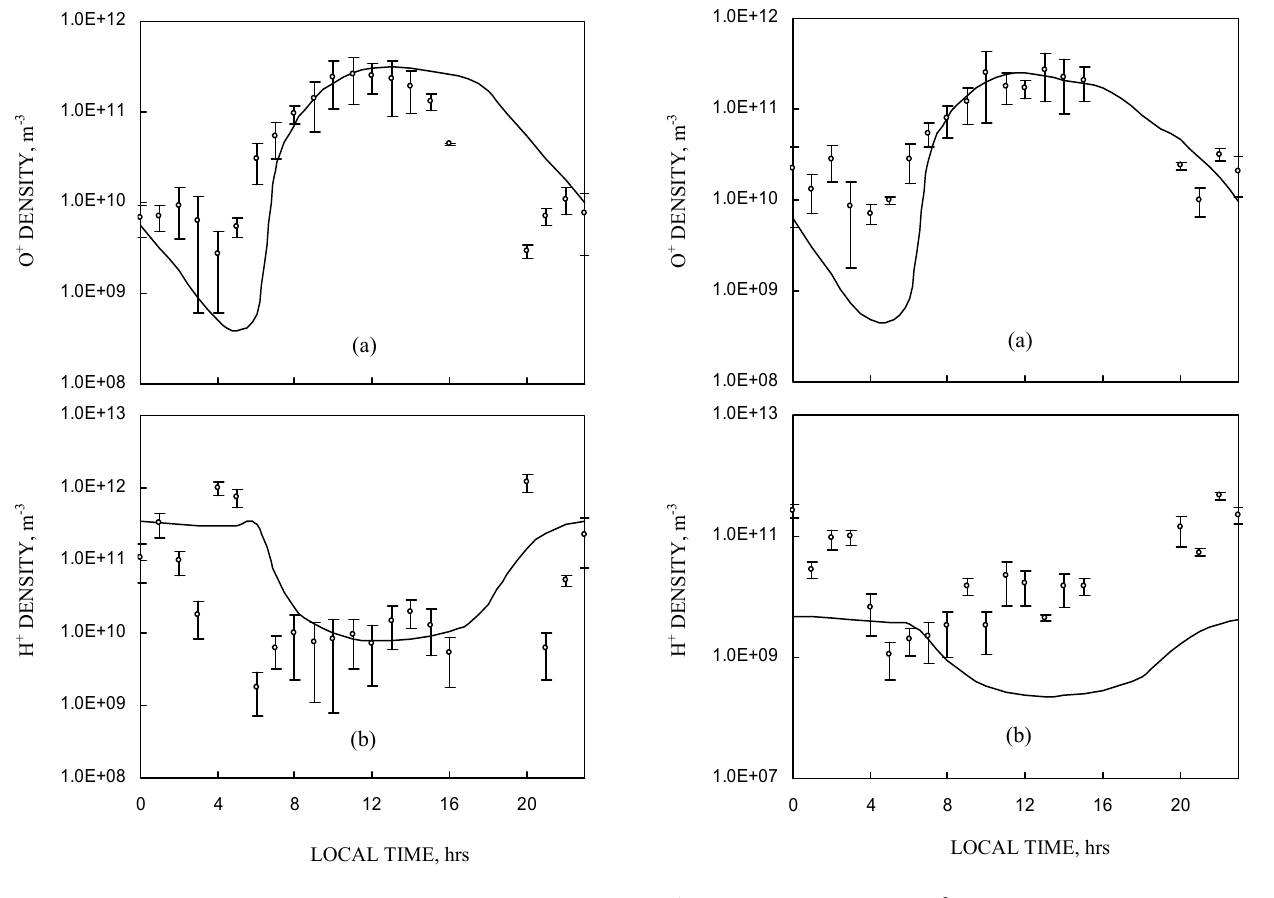
Fig. 6. Local time variation of measured (o) and simulated (—-) O + density (a) and H + density (b) at ∼ 500km altitude in the Indian zone over the geomagnetic equator in the June solstice at solar minimum.